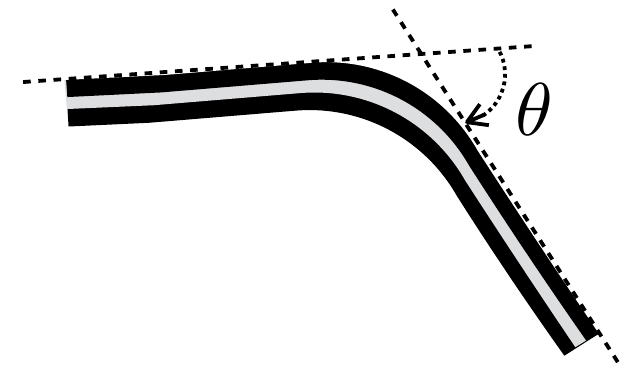
Figure 1. Representation of a double-layer textile goniometer. The two external stripes represent the piezoresistive layers. The grey line is the electrically-insulating layer. The bending angle ( θ ), represented by the angle between the tangent planes to the goniometer extremities (black dashed stripe), is proportional to the difference of the resistance ( ∆ R ) of the sensing layers.